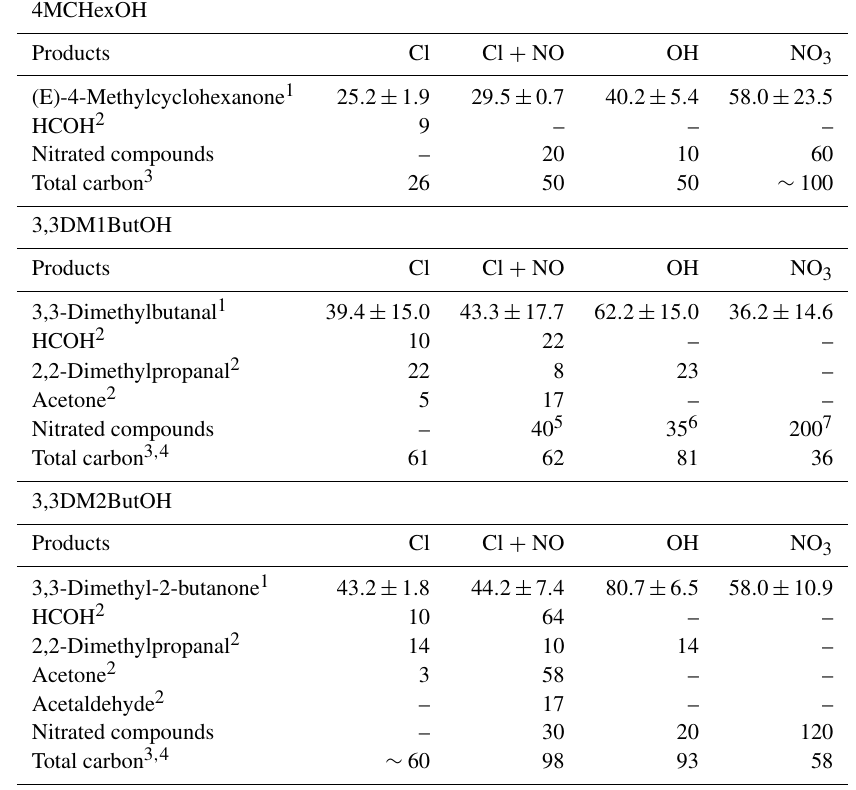
Table 6. Summary of molecular yields (%) of reaction products identified in the reaction of SAs with atmospheric oxidants and the total carbon balance (%).